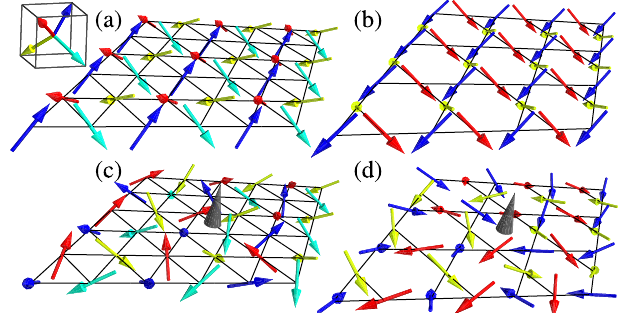
FIG. 1. (a) Chiral spin ordering on the triangular lattice. Four orientations of the local magnetic moments form a regular tetrahedron. (b) Chiral spin ordering on the kagome´ lattice. (c) Vortex configuration on the triangular lattice. (d) Vortex configuration on the kagome´